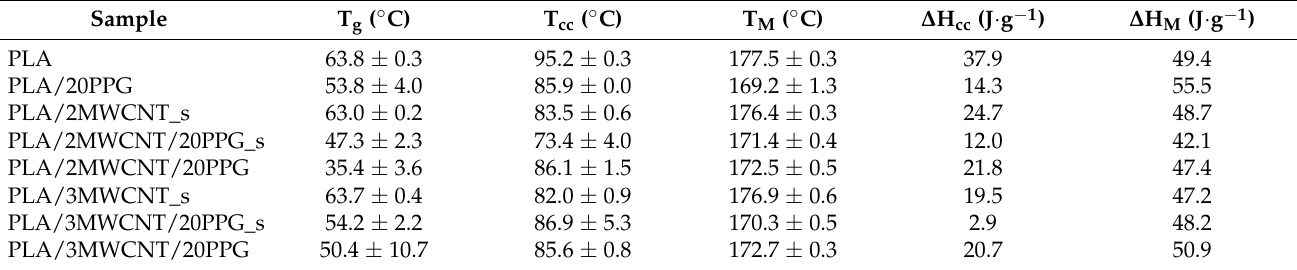
Figure 7. Representative differential scanning calorimetry (DSC) scans of ( a ) neat PLA filaments and composite filaments with MWCNT, and ( b ) composite filaments with PPG. Table 5. Glass transition temperature, T g ; cold crystallization temperature, T cc ; melting temperature, T M ; enthalpy of cold crystallization, ∆ H cc ; and enthalpy of melting, ∆ H M , as measured by DSC analysis for PLA and MWCNT composites.